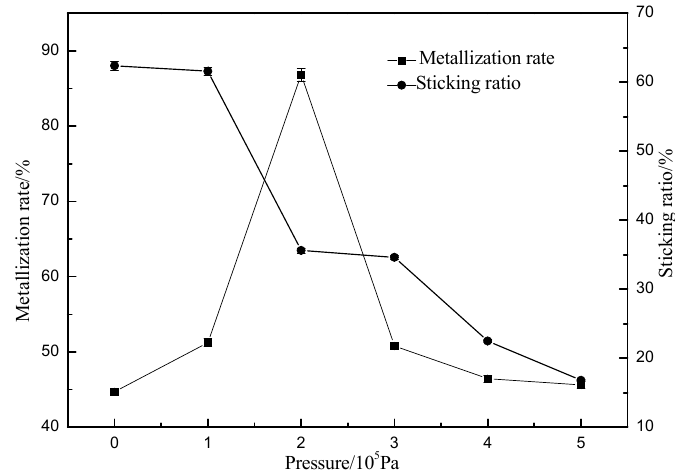
Figure 4. Trend of the metallization rate and sticking ratio with changing pressure when 0.18 mm– 0.66 mm of OMC fine iron ore is reduced by pure carbon monoxide at 1023 K, 0.8 m/s after 50 min. As shown in Figure 4, with the increase of the reduction pressure, the metallization rate increases first and then decreases. When the pressure is 0.2 MPa, the metallization rate reaches up to 86.82%. When the reduction pressures are atmospheric pressure, 0.1 MPa, 0.3 MPa, 0.4 MPa, and 0.5 MPa, the metallization rate fluctuates in the range of 44.70–51.25%. With the increasing of pressure, the sticking ratio exhibits a trend of oscillation with an overall decrease. When the reduction pressure is 0.5 MPa, the sticking ratio is the smallest but the metallization rate is relatively low; when the reduction pressure is 0.2 MPa, the sticking ratio is 35.62%, the sticking phenomenon is not found, and the metallization rate is the highest.